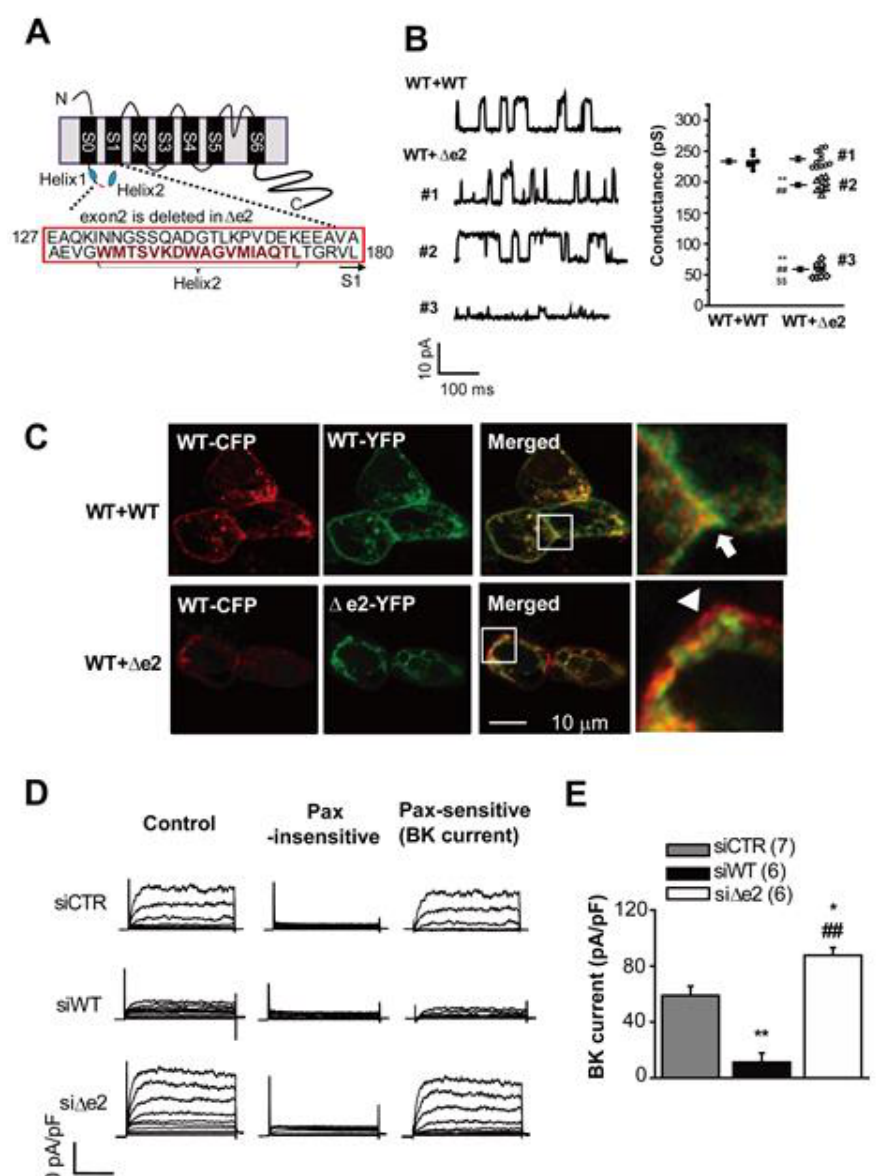
Figure 4. ( A ) Schematic diagram of BK α ∆ e2. This splice variant lacks exon2, which codes approximately half of S0-S1 linker (C-terminal side) and first two residues ( 179 VL 180 ) in the S1 segment ( B ) Single channel currents (left) were obtained at + 50 mV from HEK cells expressing both control or wild type (BK α WT) and splice variant ( ∆ e2). In control cells (WT + WT), these unitary currents show a single amplitude distribution pattern with a peak at 11.2 pA. In contrast, the amplitude histogram in WT + ∆ e2 includes three distinct groups of single channel amplitudes (#1, 11.1 pA; #2, 9.7 pA; #3, 3.5 pA). (Right) Summary of single channel conductances in WT + WT and WT + ∆ e2. **, p < 0.01 vs. WT + WT; ##, p < 0.01 vs. #1; $$, p < 0.01 vs. #2. ( C ) Confocal images of cells co-expressing WT-CFP + WT-YFP (top row), or WT-CFP + ∆ e2-YFP (lower row). Note that in merged and expanded areas (enclosed by squares) in WT + WT, significant co-localization (yellow) at the plasma membrane (PM) is observed as indicated by the arrow. In contrast, the WT + ∆ e2, CFP fluorescence signal (red) indicates no co-localization at the PM as shown by the arrow. ( D ) Outward currents recorded in OUMS-27 cells treated with siRNA specifically targeting WT or ∆ e2. Currents recorded before (left) and after (middle) the application of 1 µ M paxilline (Pax, a selective BK Ca channel blocker) are shown along with Pax-sensitive currents (BK Ca current, right). ( E ) Comparisons of these current densities at + 120 mV. *, p < 0.05; **, p < 0.01 vs. siCTR; ##, p < 0.01 vs. siWT. This research was originally published in the J. Biol. Chem. 2016; 291:24247–24260. (c) the American Society for Biochemistry and Molecular Biology (see